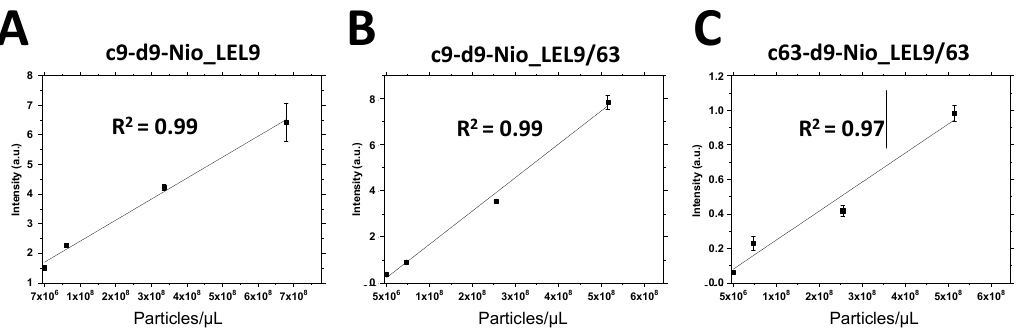
Figure 6. Dose-response graphs for different types of fully artificial exosomes detected by ELISA assay using monoclonal and polyclonal antibodies α -tetraspanins CD9 and CD63 for capture “c” and detection “d”, respectively. As secondary appropriate α -IgG-HRP was used. Nio_LEL9 ( A ) and Nio_LEL9 / 63 ( B , C ) are mono- and double-functionalized LEL-tetraspanin niosomes, respectively.